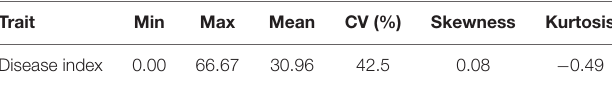
TABLE 1 | Statistical analysis and variation for FLS race 1 resistance among the association panel. Trait Min Max Mean CV (%)